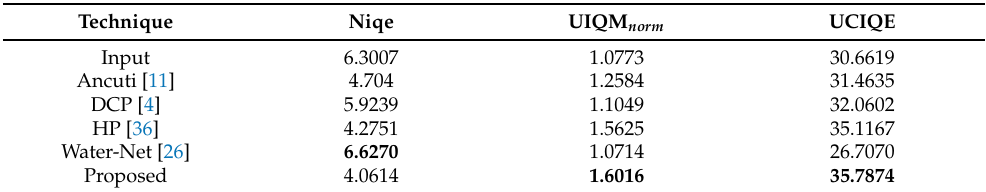
Table 2. Average niqe, UIQM norm , UIQE comparison of different techniques whose results are partially presented in Figure 6. The best result is bold.